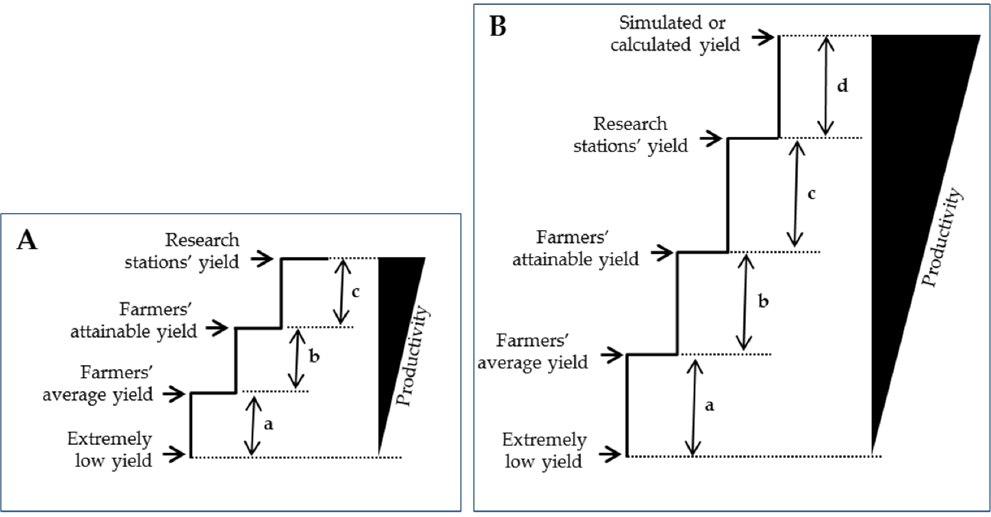
Figure 3. Sketch showing the contribution of different yield potentials to productivity of crops under rain ‐ fed or moisture ‐ limited ( A ), and irrigated or moisture ‐ unlimited ( B ) conditions. Lower case rain-fed or moisture-limited ( A ), and irrigated or moisture-unlimited ( B ) conditions. Lower case letters letters show the yield gap between the two consecutive yield levels. show the yield gap between the two consecutive yield